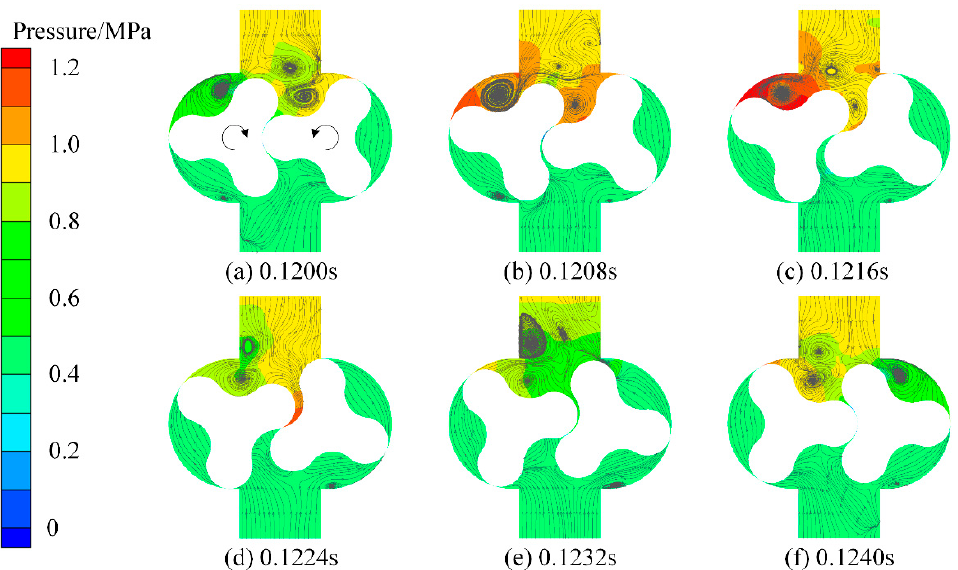
Figure 9. Pressure streamline contours of the Roots pump when the inlet CO 2 volume fraction is 0.95. Flow time: ( a ) 0.1200 s; ( b ) 0.1208 s; ( c ) 0.1216 s; ( d ) 0.1224 s; ( e ) 0.1232 s; ( f ) 0.1240 s.